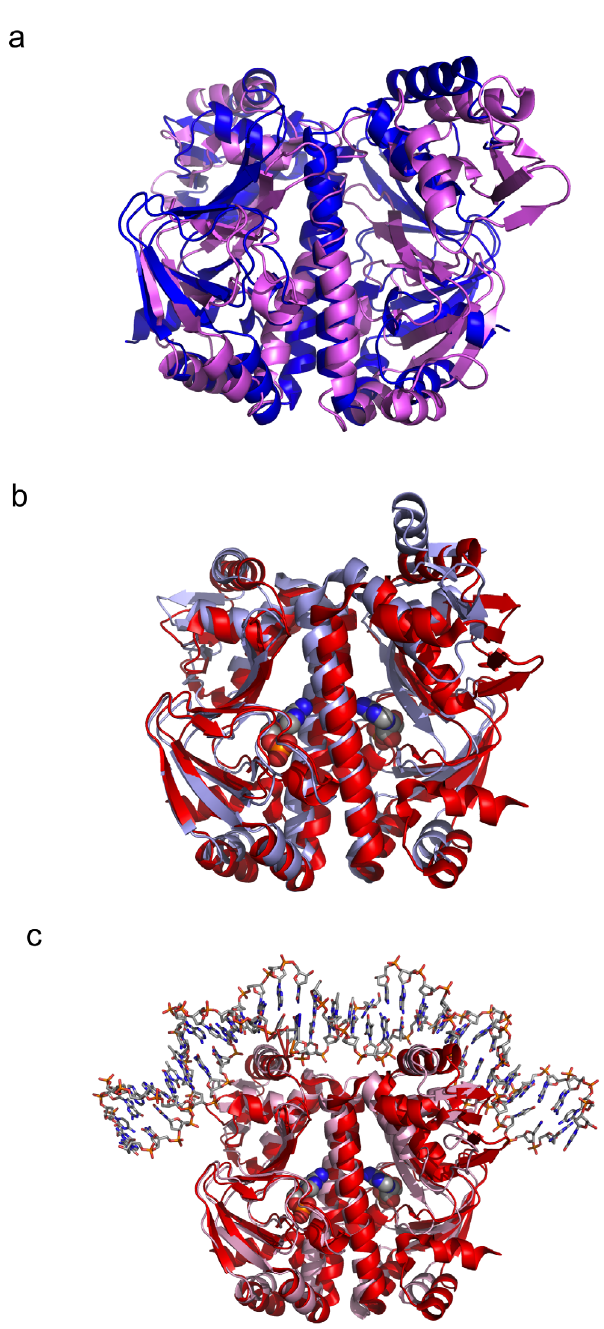
Figure 6. Superpositions of the crystal structure of Cg-GlxR with Ec-CRP. a) apo Cg-GlxR in blue with the NMR structure of Ec-CRP in magenta (PDB code 2WC2) b) holo Cg-GlxR (in red) superimposed on cAMP bound Ec-CRP (PDB code: 1G6N) shown in light blue; c) holo Cg-GlxR (in red) superimposed on cAMP- bound Ec-CRP as bound to DNA (PDB code: 1J59) shown in